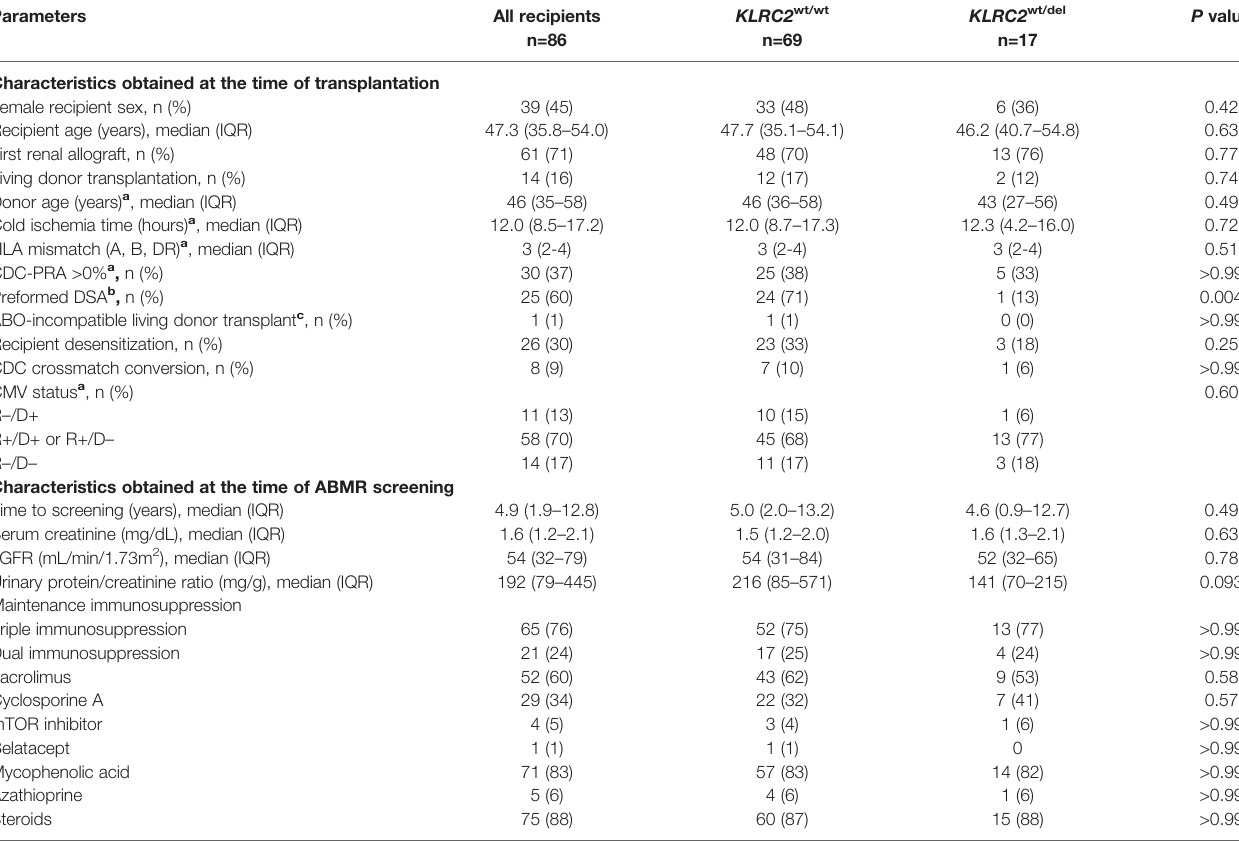
TABLE 1 | Baseline characteristics - cohort 1 (BORTEJECT trial). Parameters All